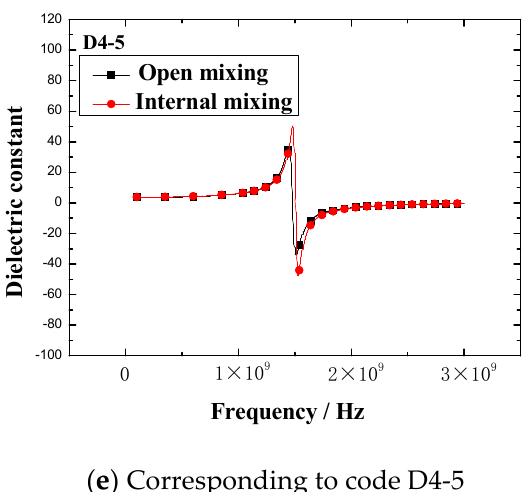
Figure 5. The dielectric constant vs. frequency plots of the rubber mixing.